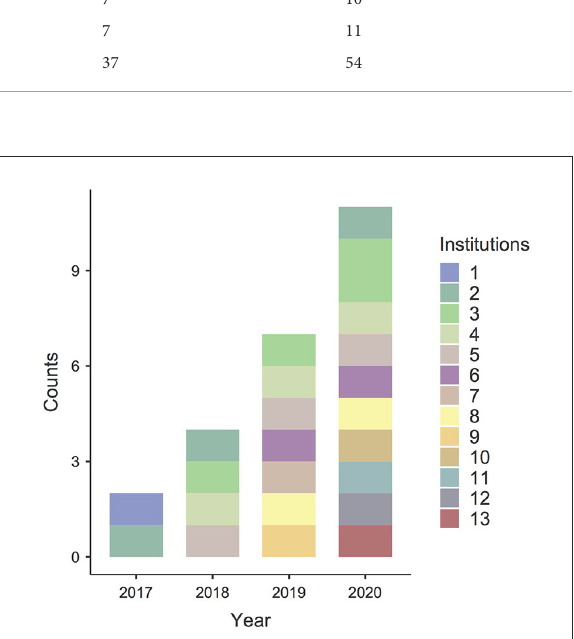
FIGURE1 Promotion of CST-Taiwan. The number of institutions delivering CST increased over time. Two institutions implemented the first two groups in Taiwan (prepilot stage) in 2017. Four institutions implemented four groups (pilot stage) in 2018. During the promotional stage, seven institutions implemented seven groups in 2019. Ten institutions implemented 11 groups in 2020. By the end of 2020, 13 institutions had joined the CST-Taiwan program and implemented 24